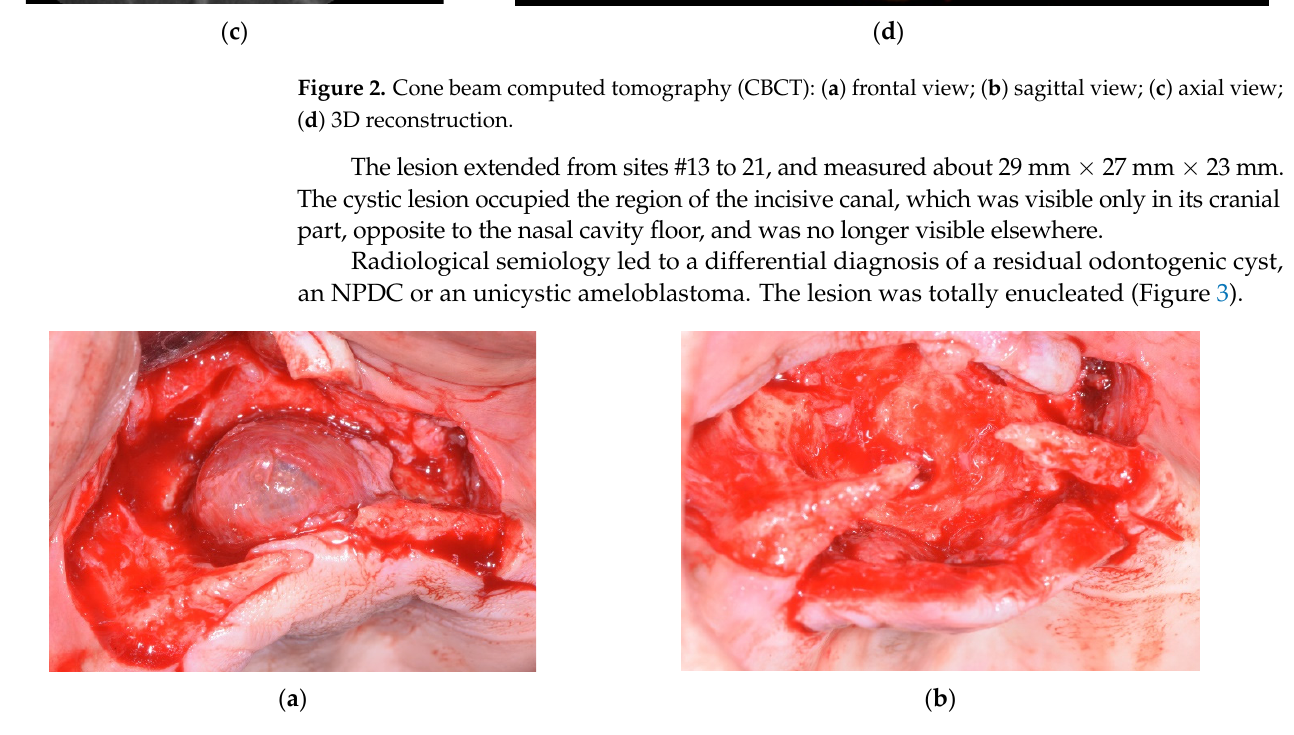
Figure 2. Cone beam computed tomography (CBCT): ( a ) frontal view; ( b ) sagittal view; ( c ) axial view; ( d ) 3D reconstruction.